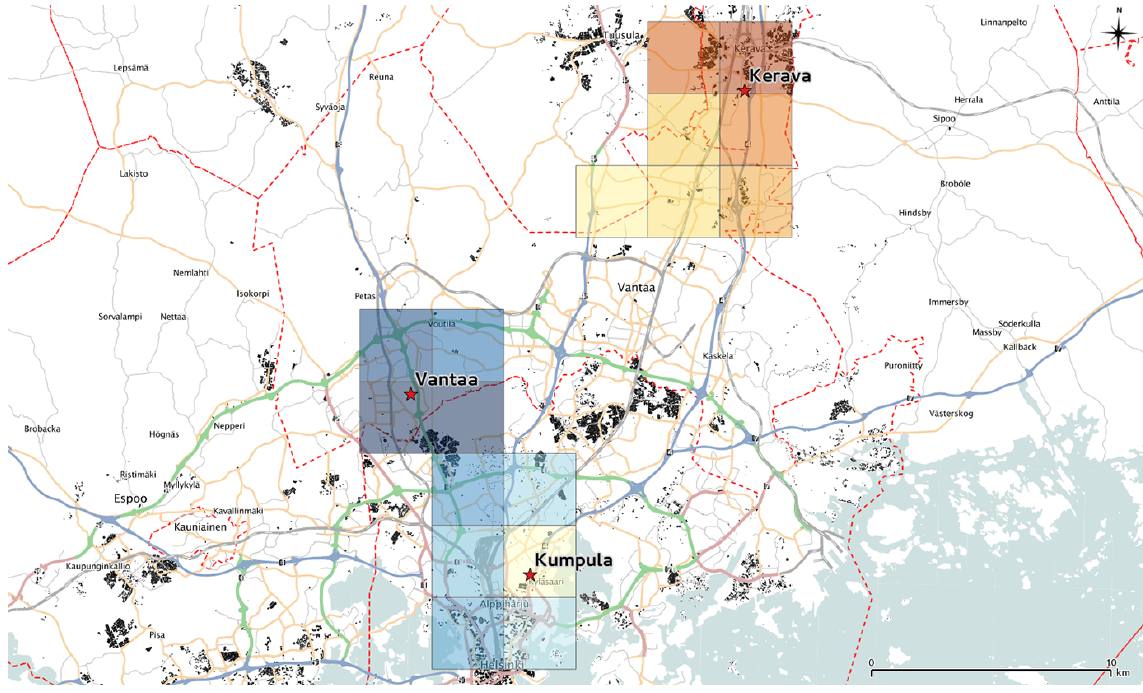
Figure 2. The ALS data tiles considered in this